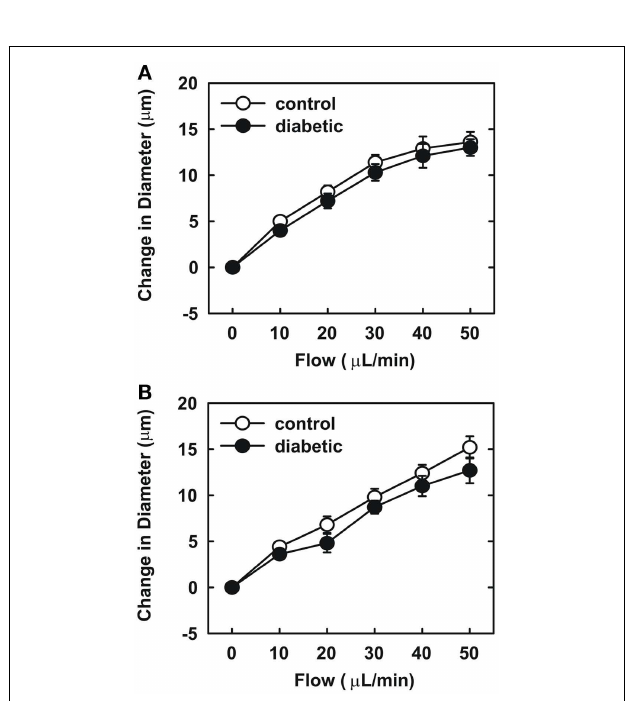
FIGURE 3 |Arginase inhibition restores flow-dependent increases in internal diameter of gracilis muscle arterioles in diabetes . Arterioles isolated from control (open circles) or diabetic (closed circles) rats were treated in vitro with the arginase inhibitors nor-NOHA (100 µ M) (A) or BEC (100 µ M) (B) and then exposed to graded levels of luminal flow. Results are expressed as mean ± SEM ( n =